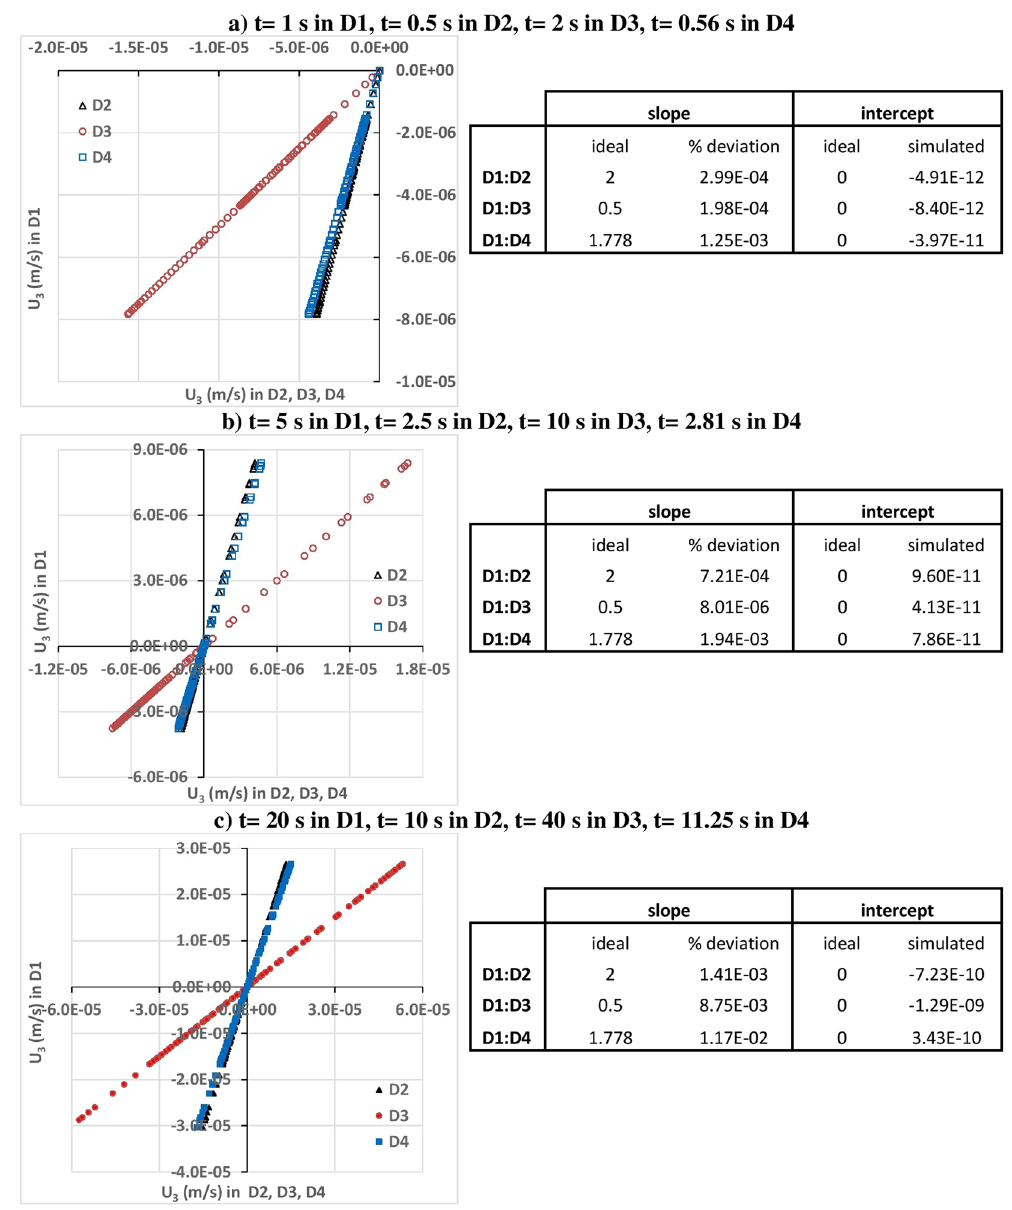
Figure 4. U 3 at simulation times ( a ) 1, ( b ) 5 and ( c ) 20 seconds along the intersection line of planes x = 0.05 m and z = 0.05 m (i.e., the centerline of the cube in x 2 direction) in domain 1 (D1) versus the corresponding velocities in domains 2, 3, and 4 (D2, D3, and D4). Simulation time of 1 s in D1 corresponds to 0.5 s in D2, 2 s in D3, and 0.56 s in D4. Simulation time of 5 s in D1 corresponds to 2.5 s in D2, 10 s in D3, and 2.81 s in D4. Simulation time of 20 s in D1 corresponds to 10 s in D2, 40 s in D3, and 11.25 s in